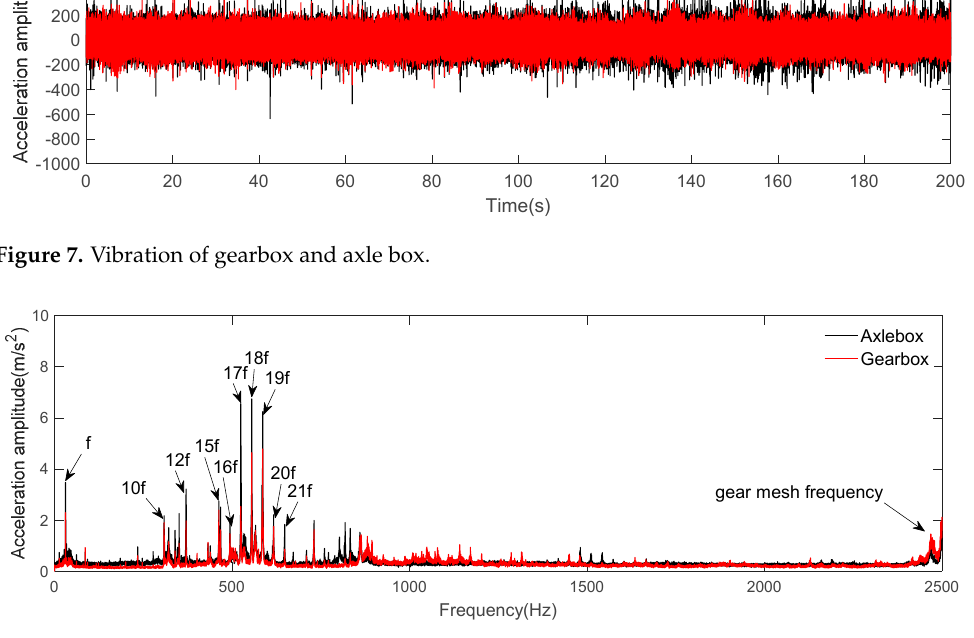
Figure 8. Spectrum of gearbox and axle box.